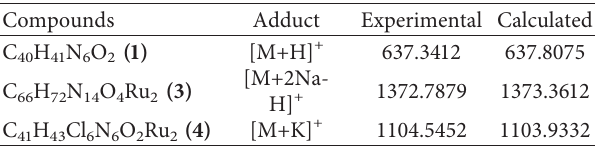
Table 4: Experimental and calculated mass analysis of